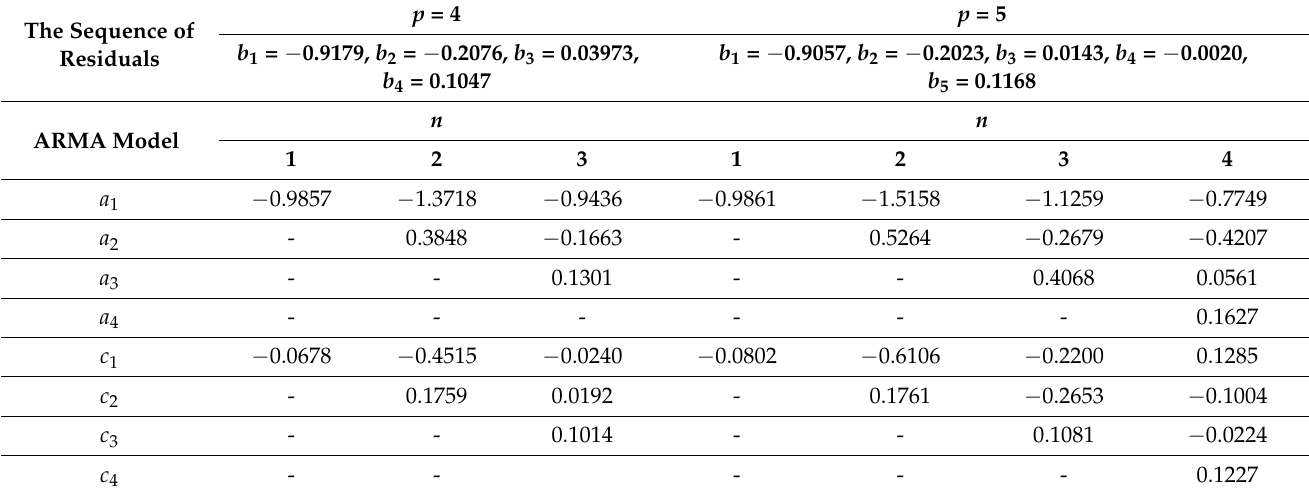
Table 2. Flow rate model parameters of coal flotation feed solids with structure (3) estimated for the first series of measured data.